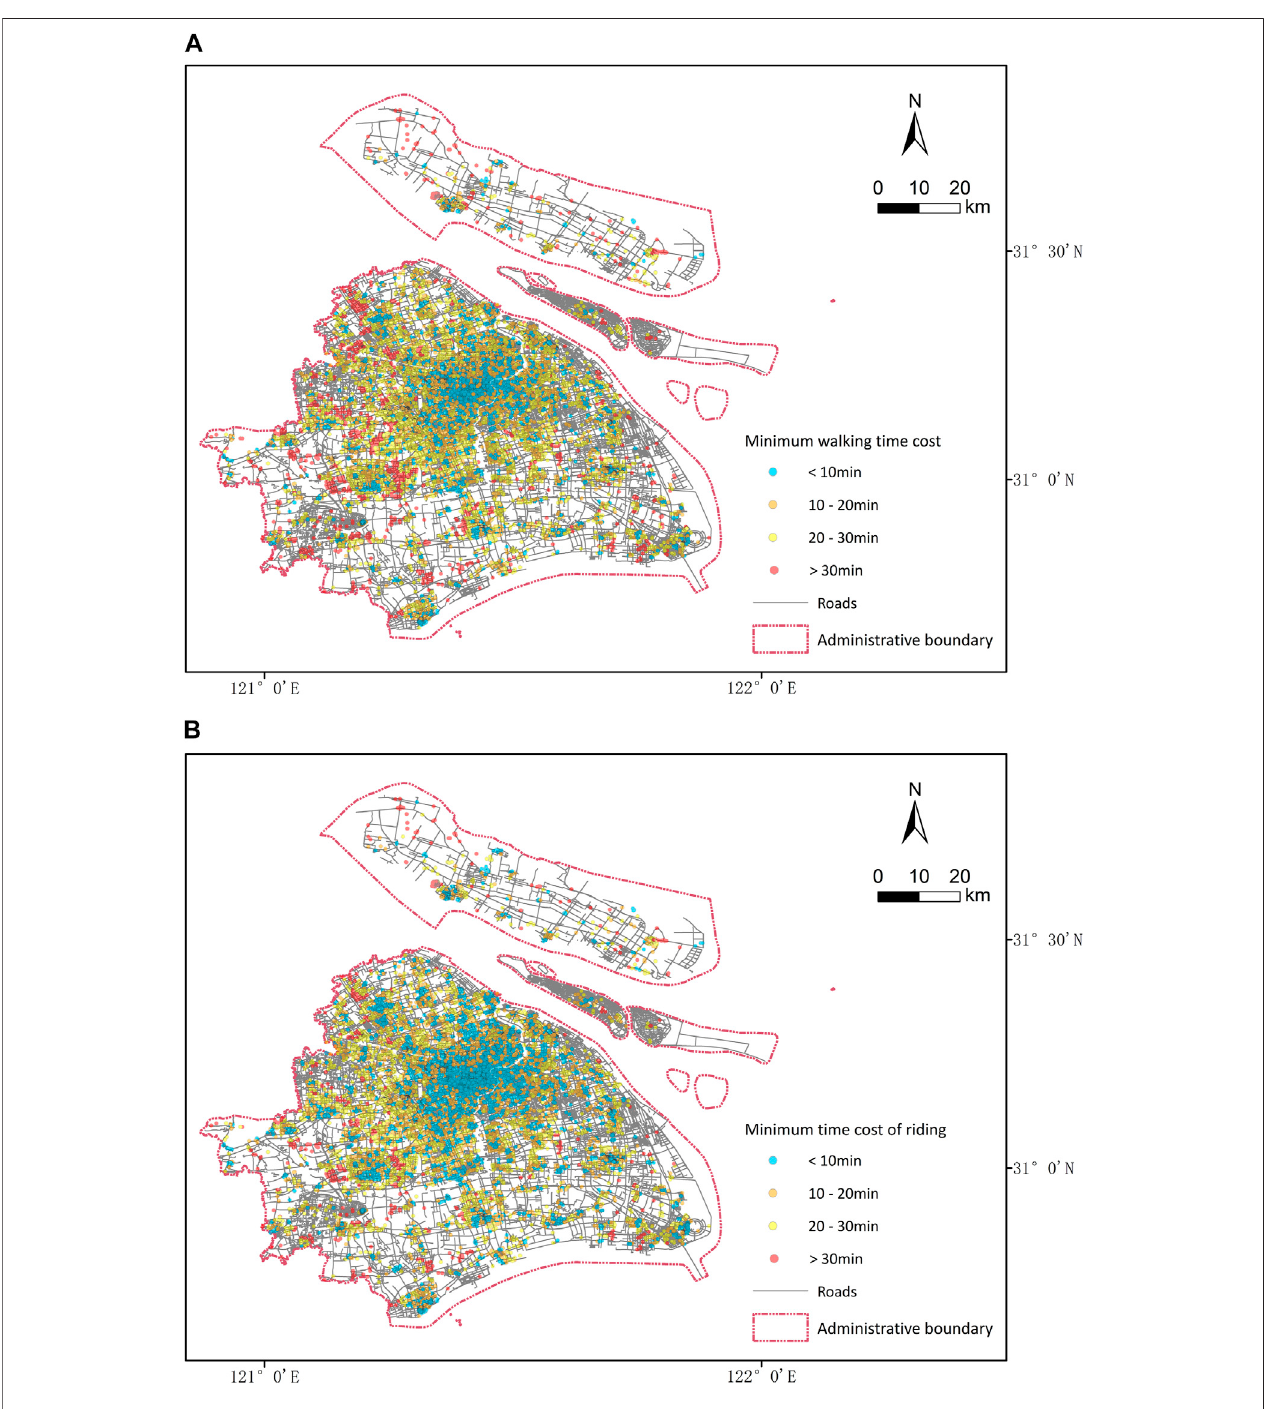
FIGURE 4 | Accessibility in residential areas. (A) walking mode and (B) cycling